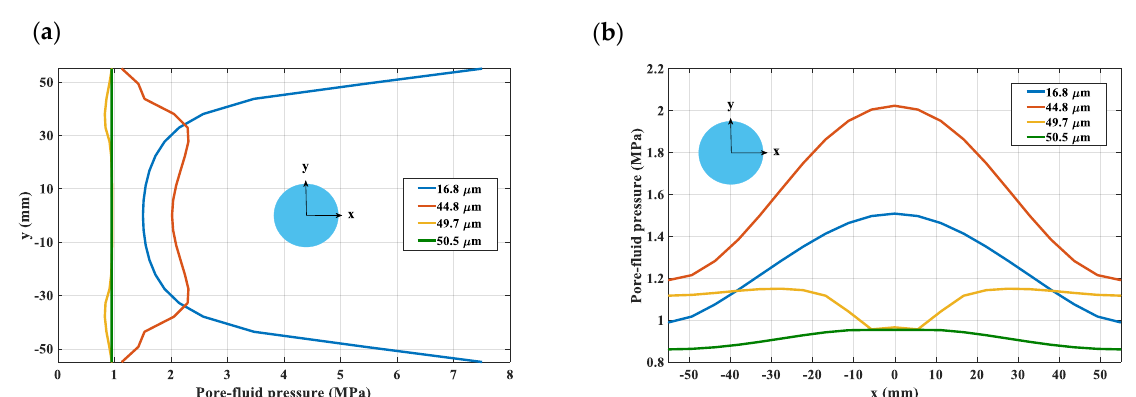
Figure 6. Profiles of the pore-fluid pressure (MPa) along ( a ) vertical and ( b ) horizontal axes at different vertical displace- ments.